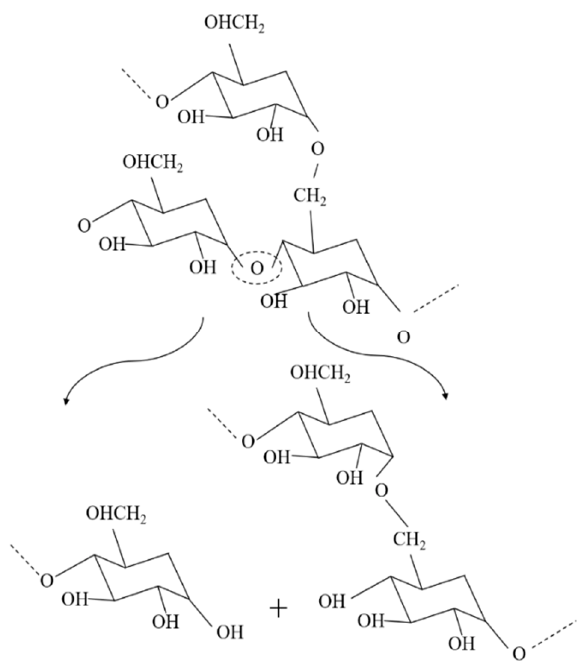
Figure 3. Schematic diagram of Solanyl thermal degradation and molecular cleavage.